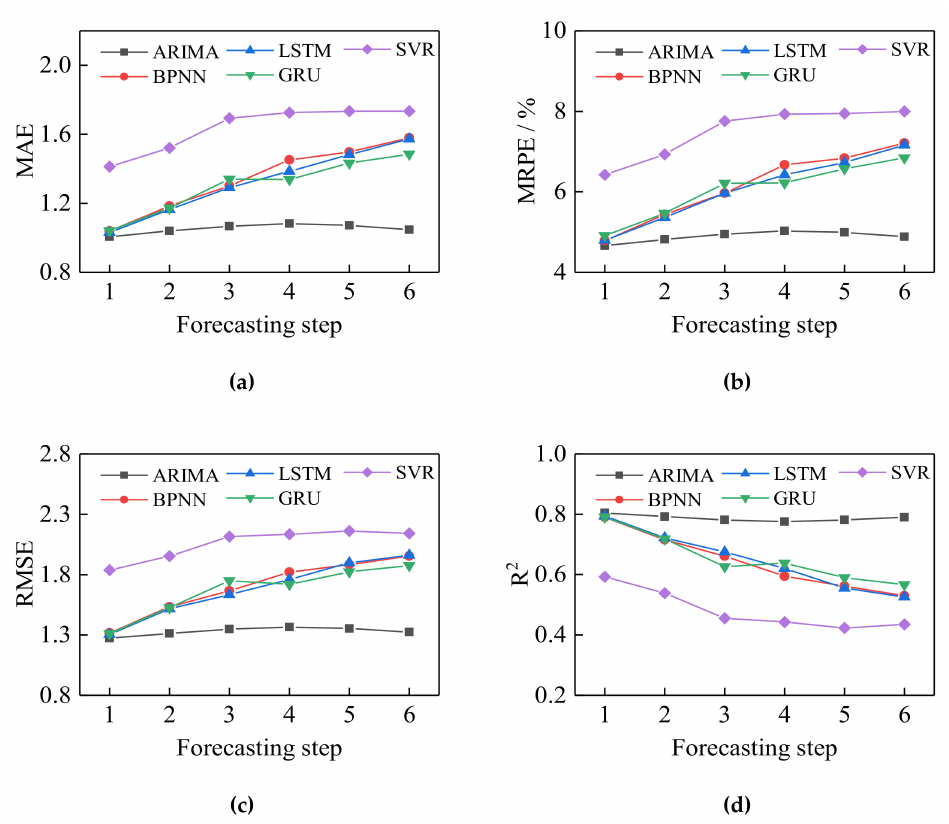
Figure 13. Multi-step forecasting errors of different models for the mean wind speed. ( a ) MSE; ( b ) MRPE; ( c ) RMSE; ( d ) R 2